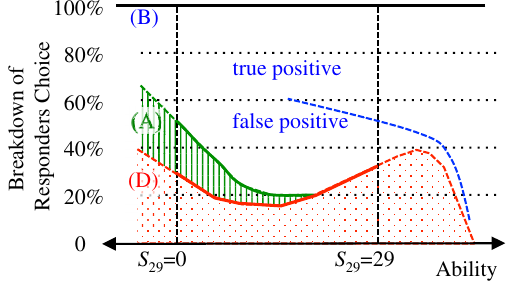
FIG. 4. Schematically simplified image of MIRC. Misconcep- tion oriented image of Q.29. The areas (A), (B), and (D) represent the percentage of responses. The rare responses of (C) and (E) are ignored. The broken lines are qualitative estimates.